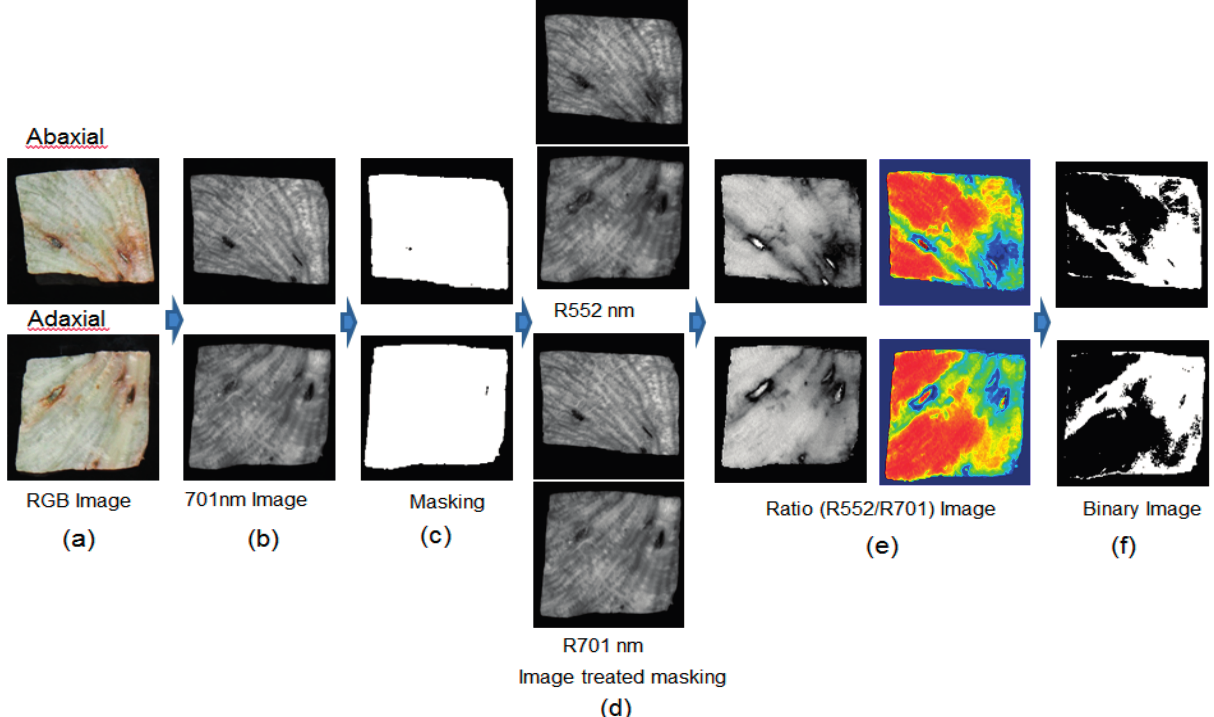
Figure 12. Illustration of image processing sequence for the RI algorithm using two wavebands: ( a ) sample images; ( b ) grayscale I 701 images; ( c ) masking images obtained by applying a threshold of 0.10 reflectance to an I 701 image; ( d ) I 552 and I 701 images after masking; ( e ) the grayscale and color ratio images of I 552 and I 701 after masking; and ( f ) resulting detection images after the application of a 0.82